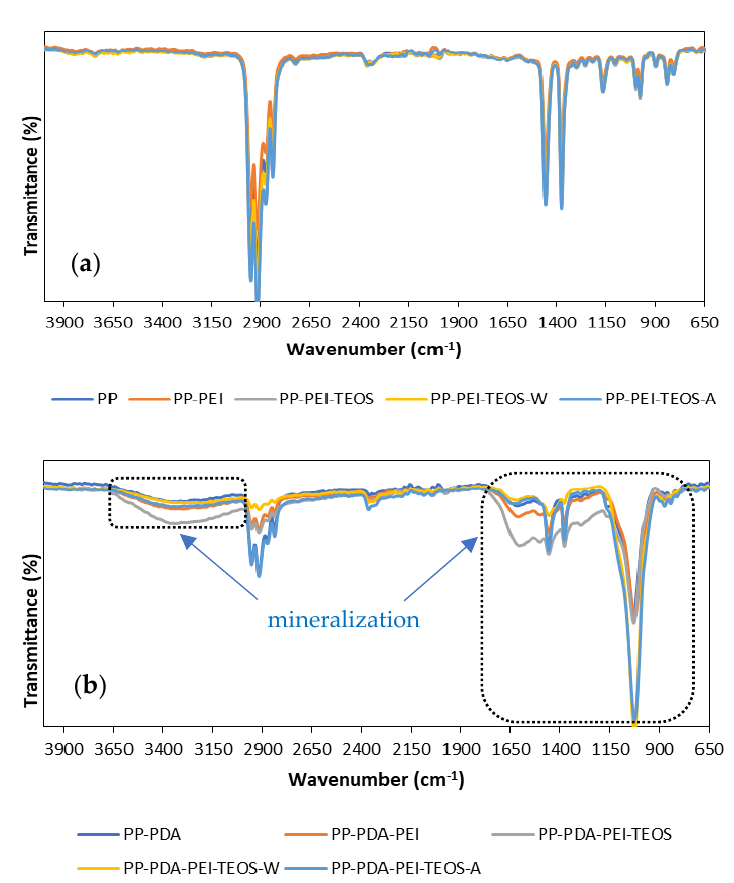
Figure 6. FTIR spectra of samples after 7 days of incubation in SBF: ( a ) PP films without PDA coating; and ( b ) PDA-modified PP films.